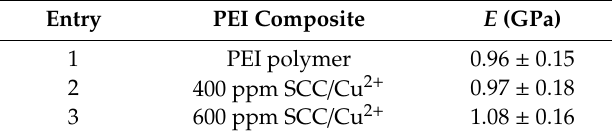
Figure 5. Scanning electron microscopy (SEM) images of coated SCC / Cu 2 + (4 / 1) on PEI film at 10,000 × ( A , side view) and 2000 × ( B , top view) magnification. Table 4. Young’s modulus ( E ) for SCC / Cu 2 + / PEI composite a